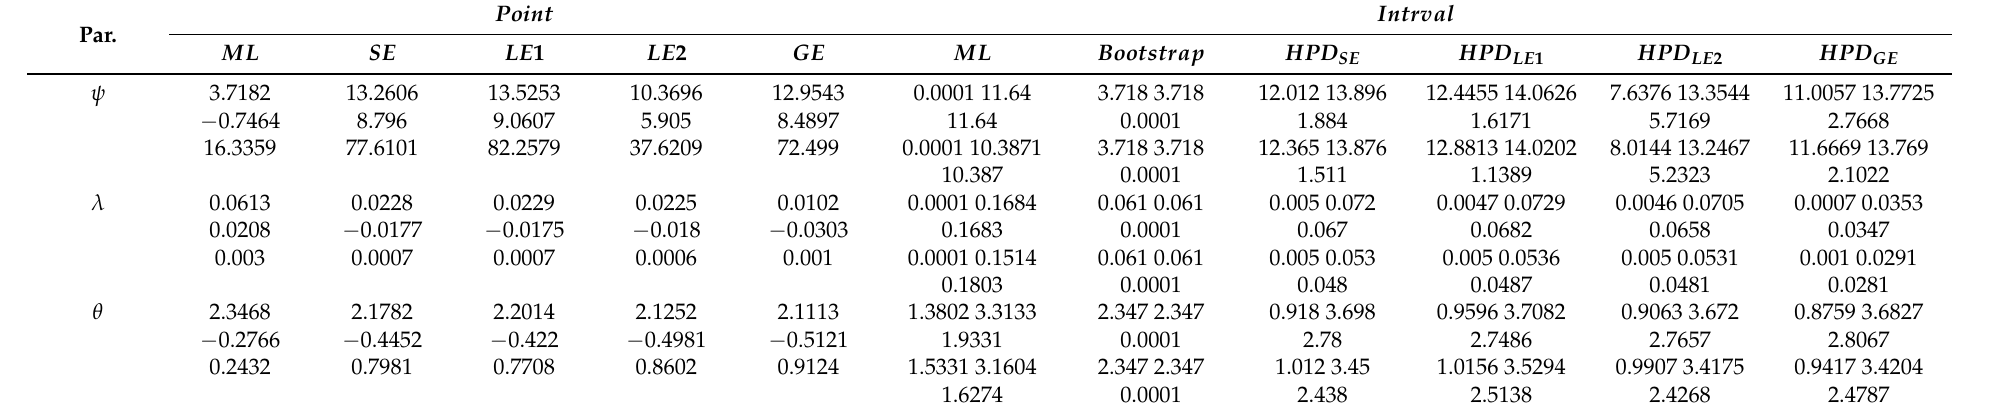
Table 7. The estimation of the parameters ψ , λ , and θ for the close